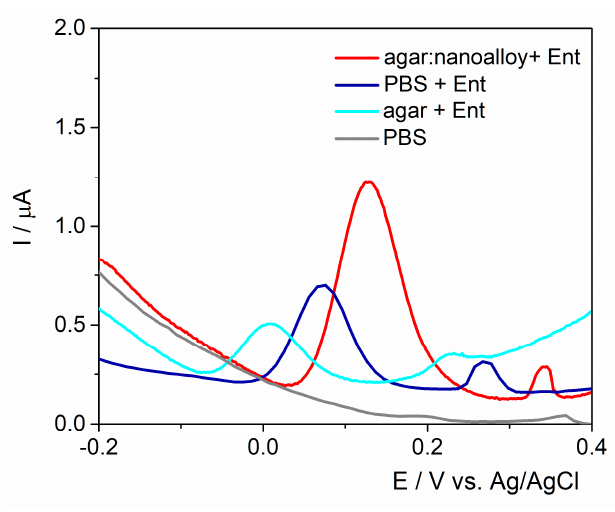
Figure 6. DPV for 25 µ M Ent with an in-lab printed electrode on glove modified with 60 µ L agar hydrogel without/with Au/Ag nanoalloy.